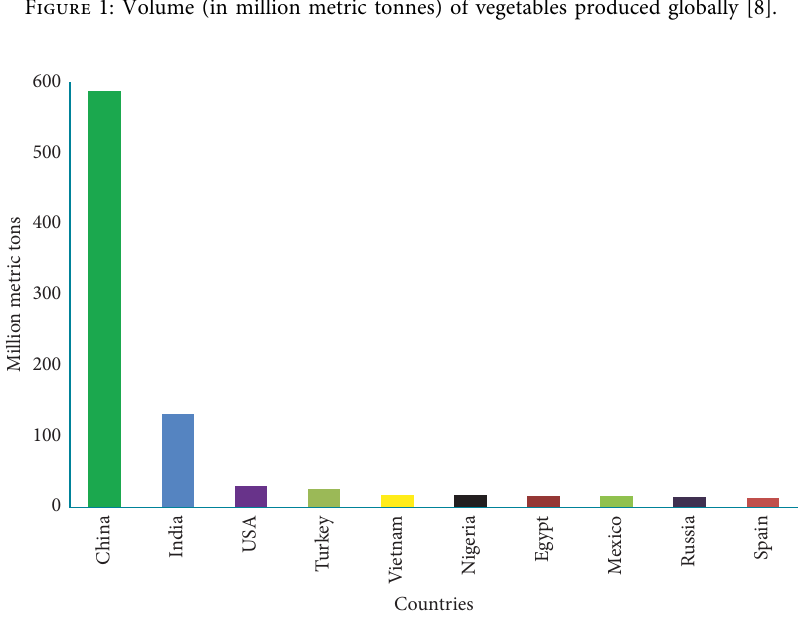
Figure 2: 2019 top ten leading producers of vegetables [8].